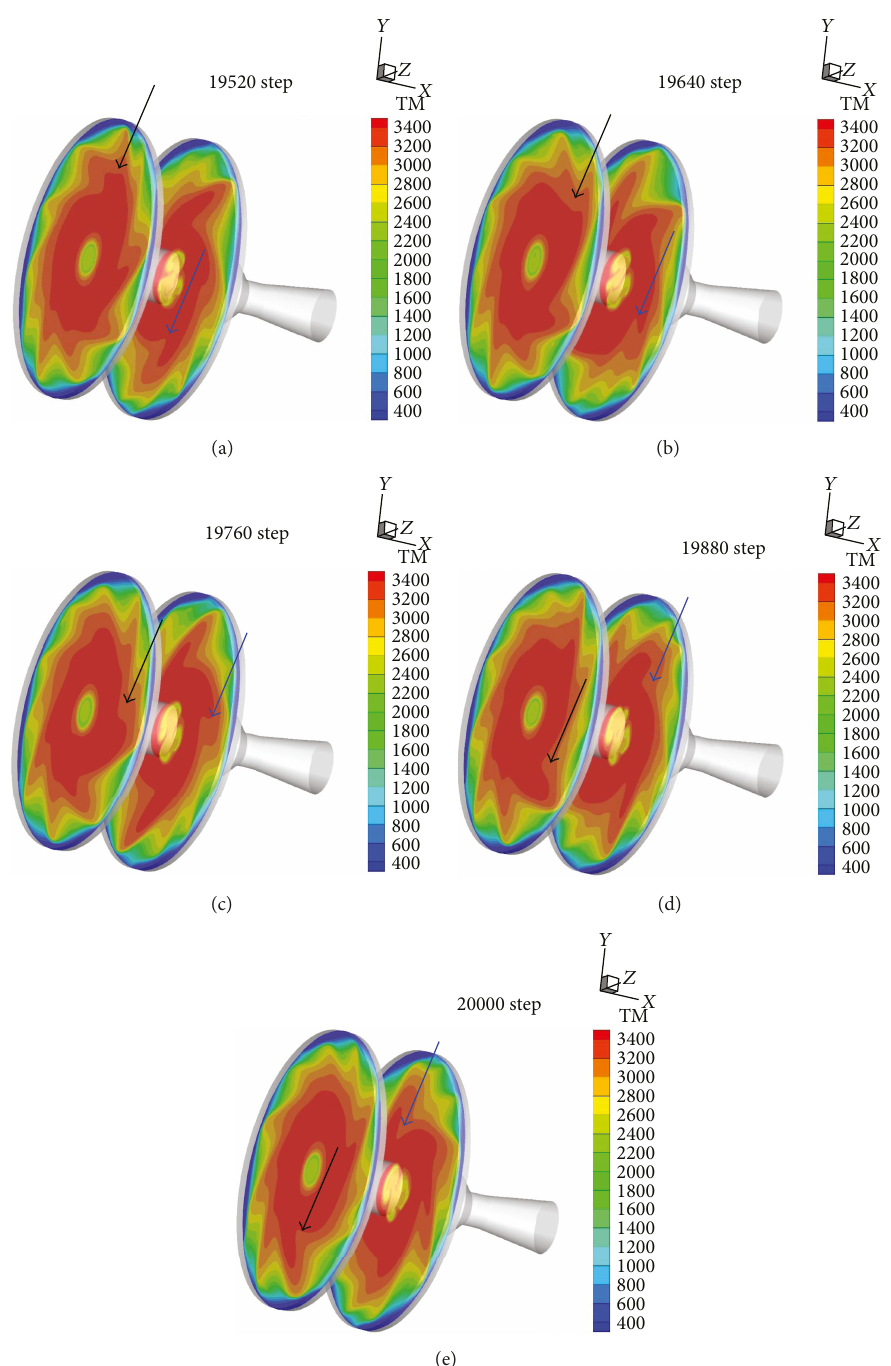
Figure 11: Temperature [K] contour of Case A at various calculation steps: (a) 19520 step, (b) 16940 step, (c) 19760 step, (d) 19880 step, and 2 (e) 20000 step. Note that the black and blue arrows show the location of the some speci fi c temperature “ spike ” in disk chamber 1 and disk chamber 2,